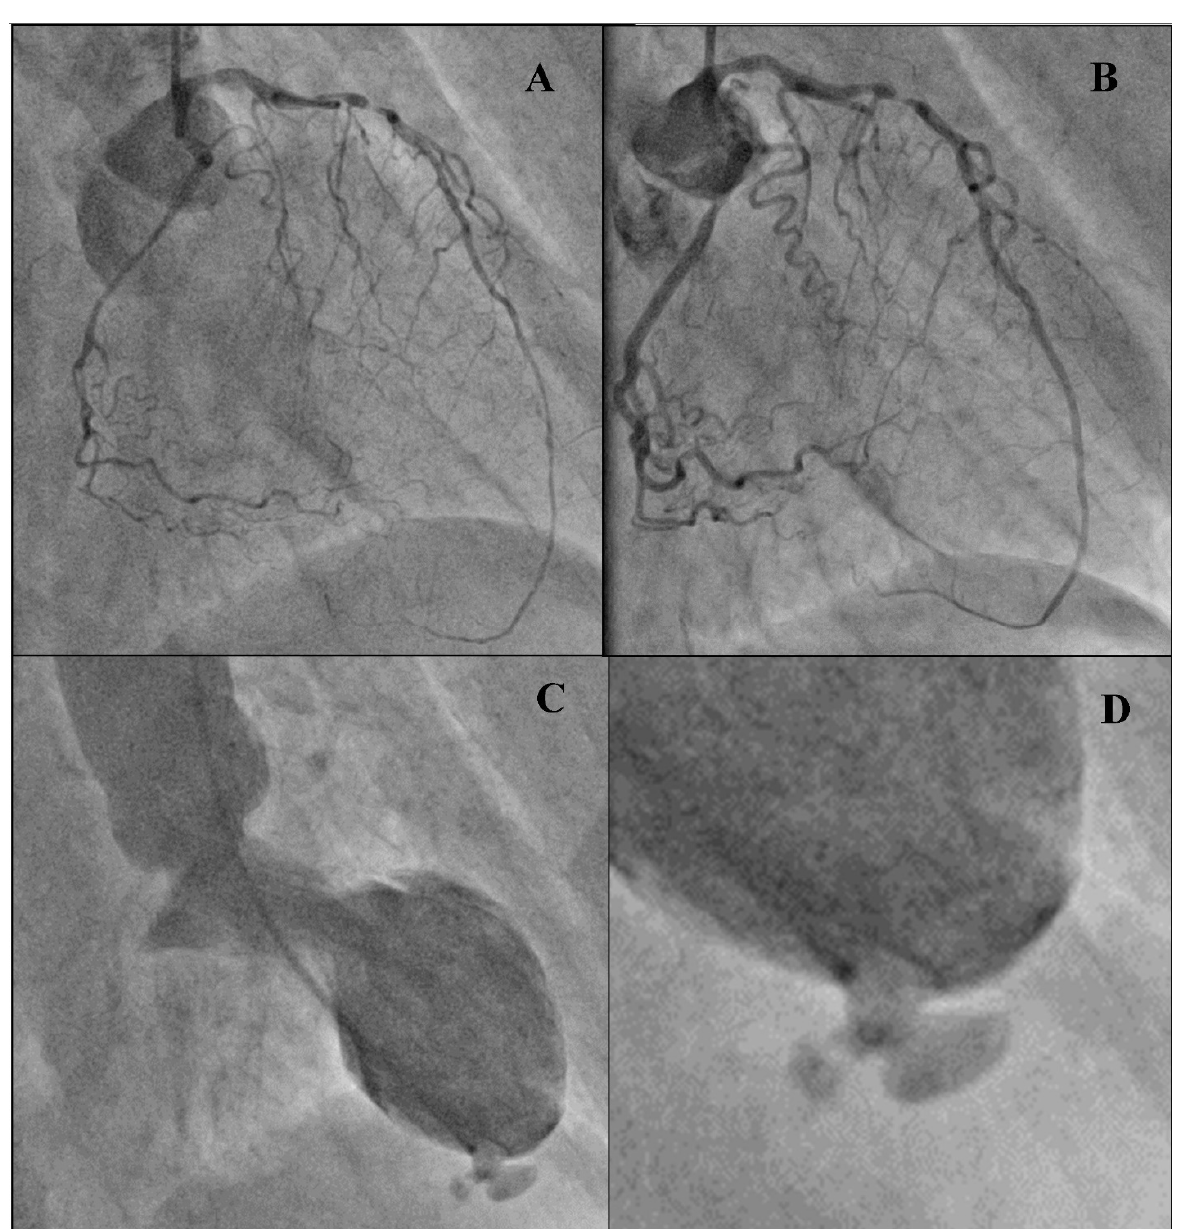
Figure 2. Coronary angiography and ventriculography: ( A ) Coronary angiogram of left artery-diffuse spasm of coro- nary vessels (30 deg. RAO). ( B ) Coronary angiogram of left artery after administration 200 μ g NTG (nitroglycerin) i.c. (intracoronary)–critical stenosis in seventh segment of the left anterior descending artery (LAD). ( C ) Ventriculography (30 deg. RAO), pig tail catheter inside left ventriculum. Systolic phase: akinesis of antero-lateral, apical and diaphragmatic segments. Pseudoaneurysm outgrowing from posterior, apical segment. ( D ). Enlargement picture with